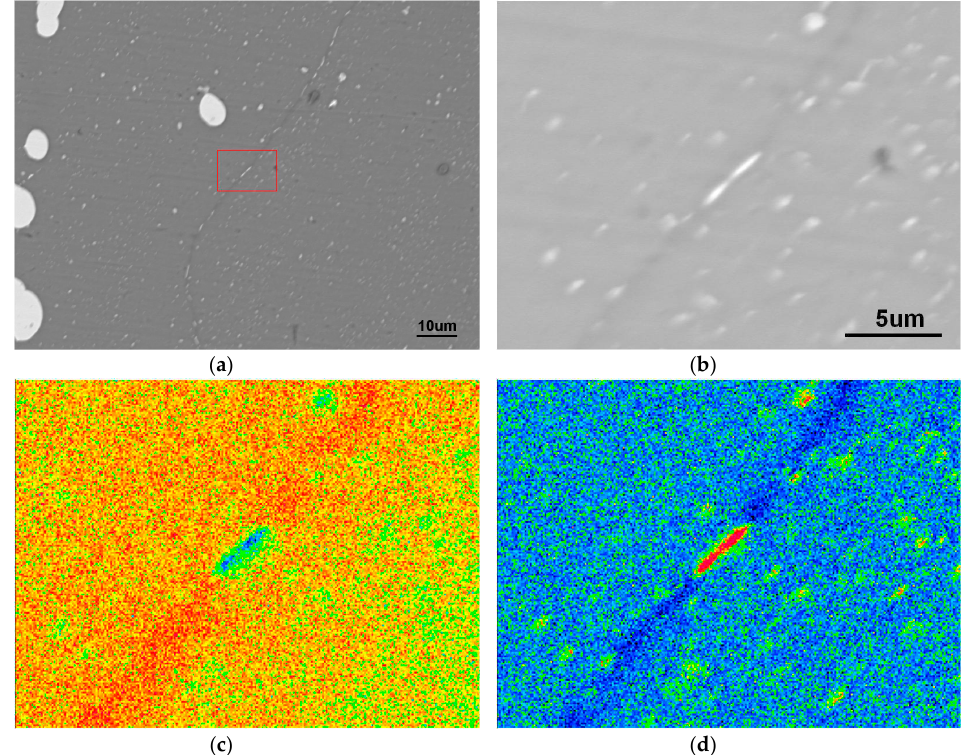
Figure 8. SEM micrographs and element distribution of solution treatment followed by water quenching 2219Al-6.52Cu alloy: ( a , b ) SEM image, ( c ) Al distribution, ( d ) Cu distribution.